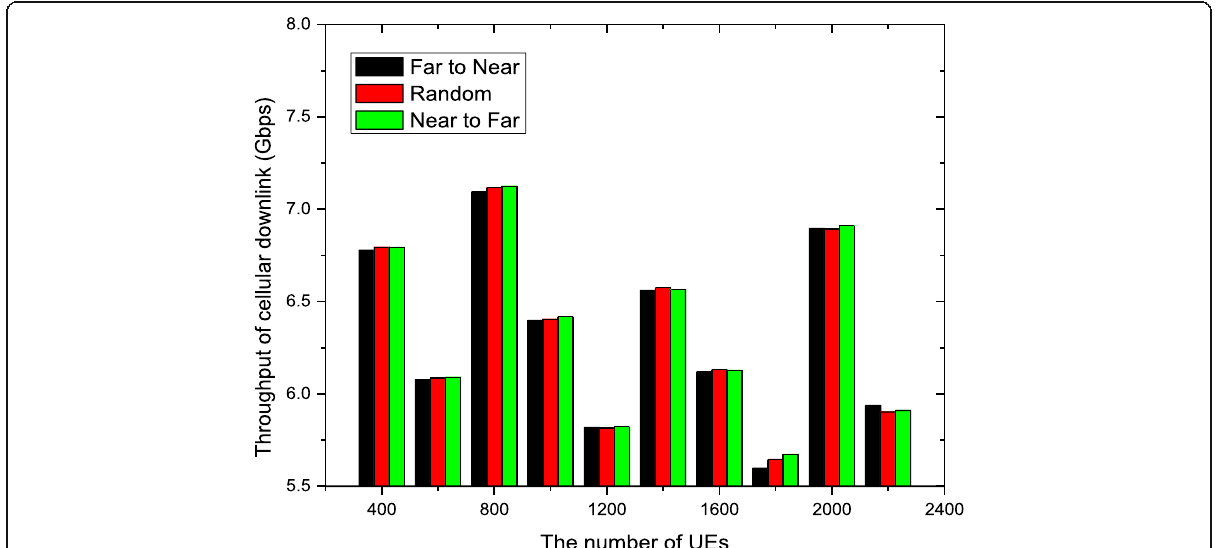
Fig. 16 Throughput for the DTO-MROD scheme under the different verification orders of relay preselection